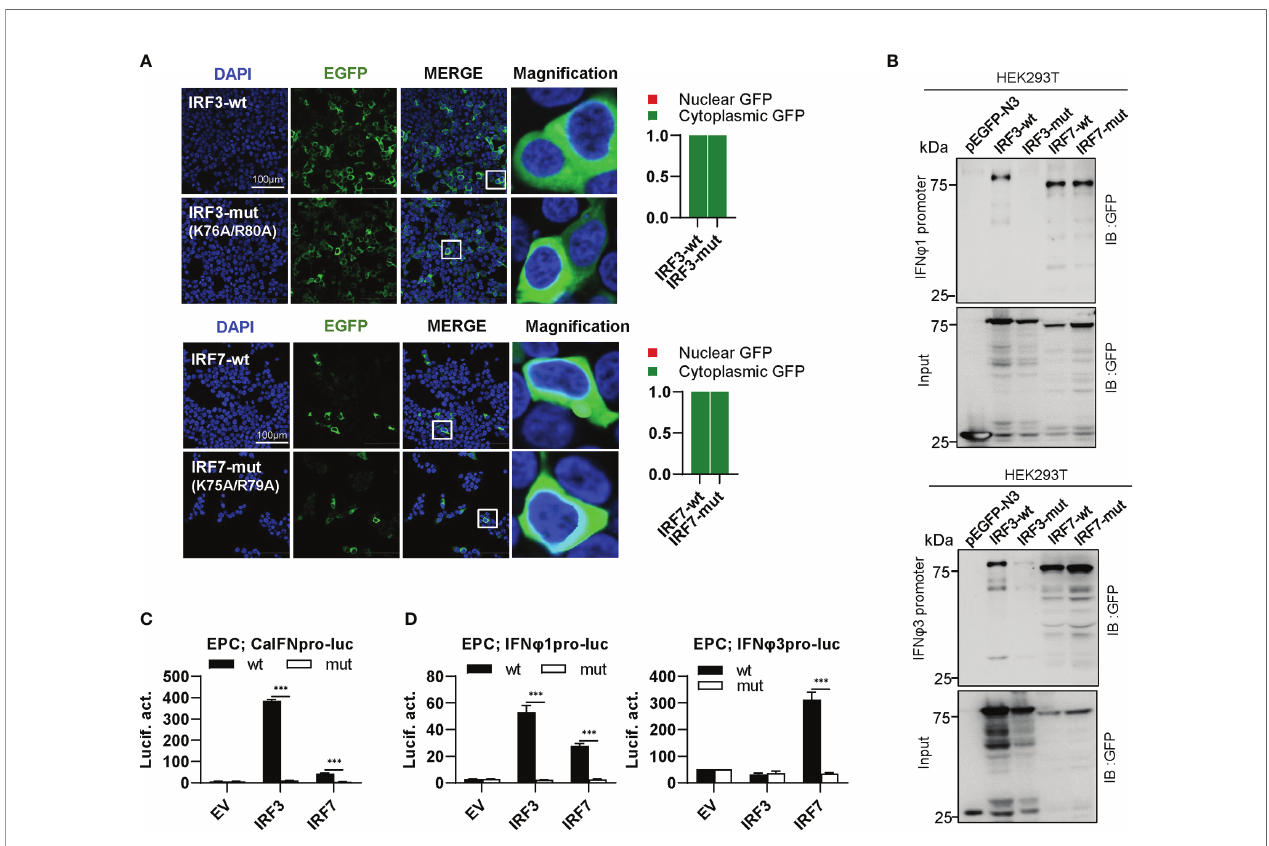
FIGURE 7 | The two basic residues are essential for IRF3/7 to stimulate IFN response. (A) Mutation of two residues did not change the constitutively nuclear accumulation of IRF3/7. Left panels: HEK293T cells seeded overnight on microscope slide cover-glasses in six-well plates were transiently transfected as in Figure 4 , with indicated plasmids (2 m g each) for 24h, followed by confocal microscopy examination. The last column showed magni fi cation view of the area highlighted in the box. Right panels: The intensities of nucleus/cytoplasm GFP were quantitated using the ImageJ processing program and normalized to that of the empty construct pEGFP-N3, which was set to 1:1. (B) Pull-down analysis of the binding af fi nity of wild types and mutants of IRF3/7 to IFN j 1/IFN j 3 promoters. DNA pull-down assays were performed as in Figure 3B , by incubation of biotin-labeled IFN j 1 or IFN j 3 promoter DNA with appropriate amounts of HEK293T cell lysates, where cells were transfected for 30h with wild types or mutants of IRF3/7, respectively. (C, D) IRF3/7 mutants failed to stimulate the activation of crucian carp IFN promoter (C) , and zebra fi sh IFN j 1/IFN j 3 promoters (D) . EPC cells seeded in 48-well plates overnight were transfected with CaIFNpro-luc (C) , IFN j 1pro-luc or IFN j 3pro-luc (D) , together with the indicated IRF plasmids (100ng each). 30 h later, cells were harvested for luciferase assays. (***P <